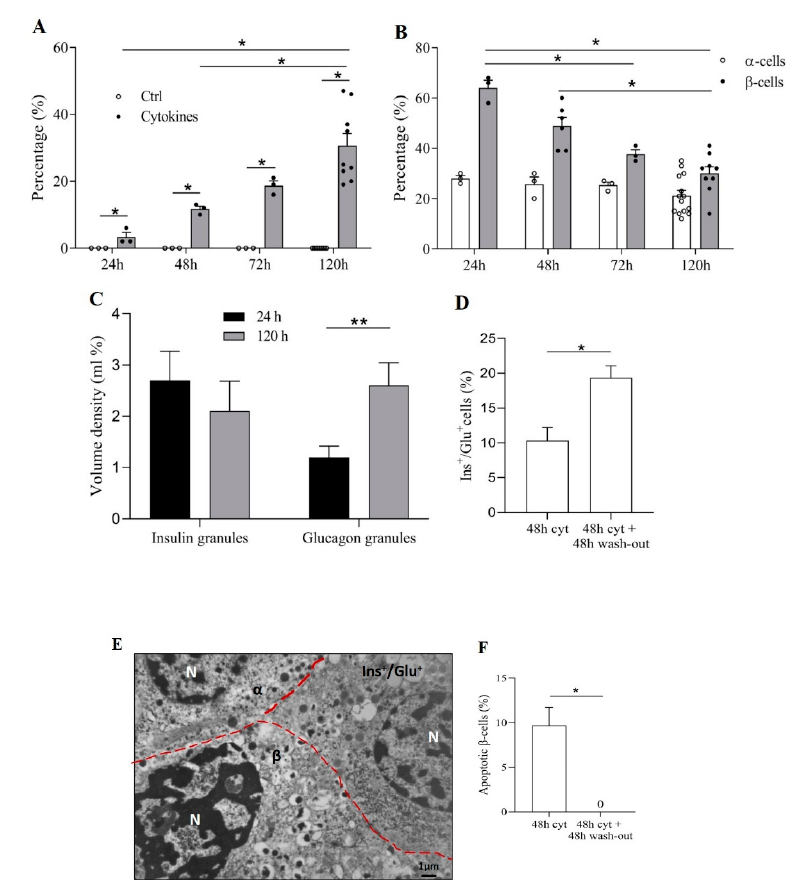
Figure 2. Pro-inflammatory cytokines induce Ins + /Glu + cells in non-diabetic (ND) human islets. ( A ) Percentage of Ins + /Glu + cells at different time points of exposure to pro-inflammatory cytokines compared to control. ( B ) Percentage of α - and β -cells at different time points of exposure to pro- inflammatory cytokines. ( C ) Volume density of insulin and glucagon granules in Ins + /Glu + cells after 24 h and 120 h cytokine exposure. ( D ) Percentage of Ins + /Glu + cells after 48 h cytokine exposure, followed or not by 48 h wash-out (medium without cytokines). ( E ) Electron microscopy image showing an apoptotic β -cell ( β ) with chromatin condensation in the nucleus (N); in the same picture a normal α -cell ( α ) and an Ins + /Glu + cell (Ins + /Glu + ) are depicted (scale bar corresponds to 1 µ m). ( F ) Percentage of apoptotic β -cells after 48 h cytokine exposure followed or not by 48 h wash-out (medium without cytokines). Percentages assessed by electron microscopy are relative to total endocrine cell number. * p < 0.05, ** p < 0.01.